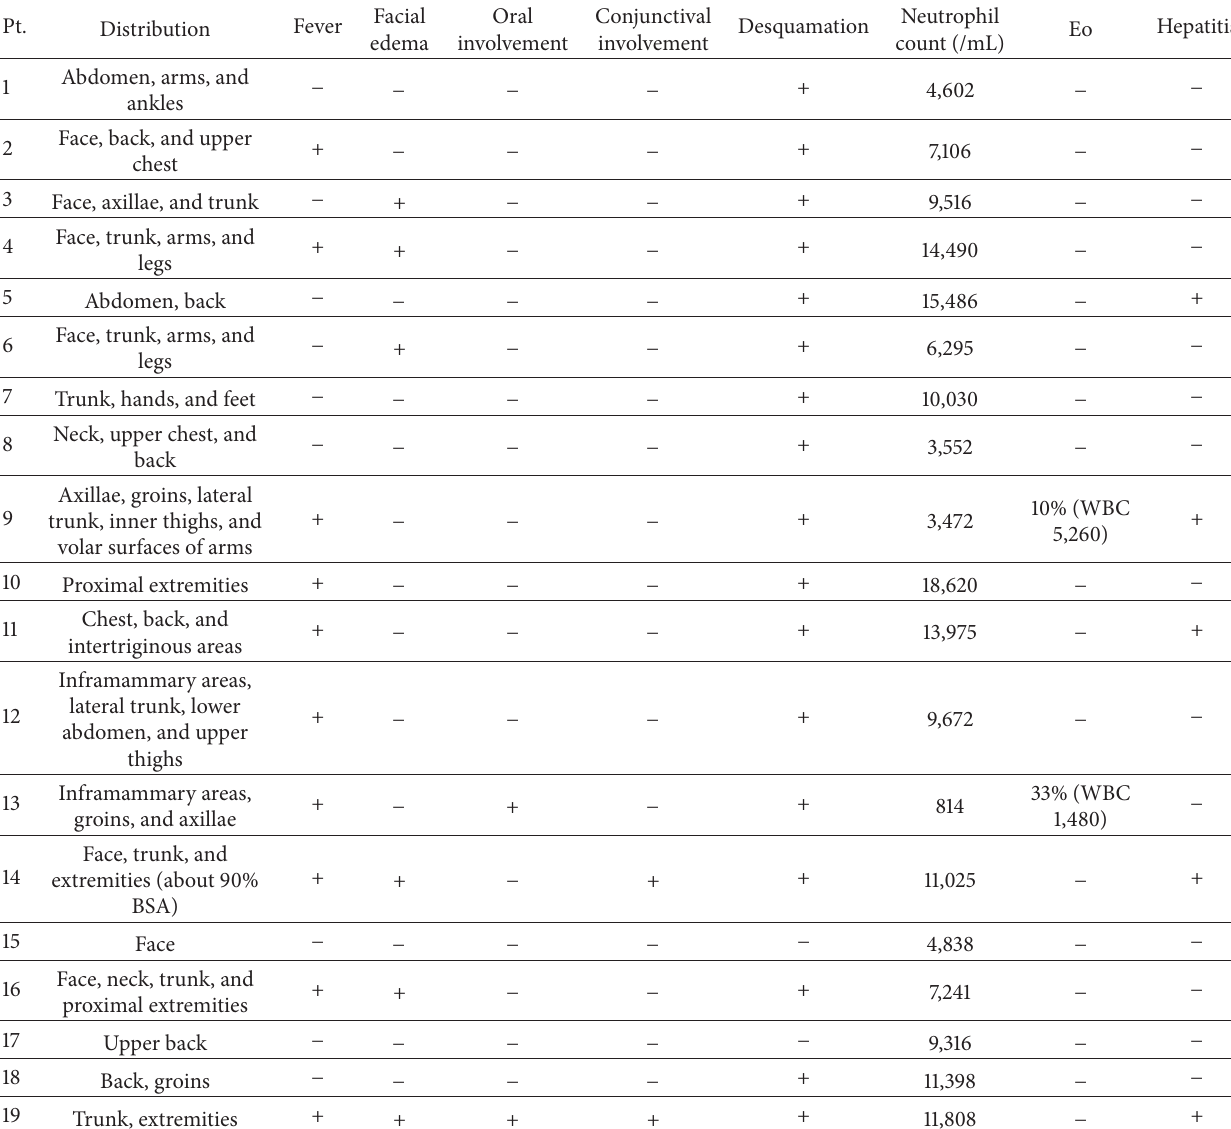
Table 3: Clinical characteristics and laboratory